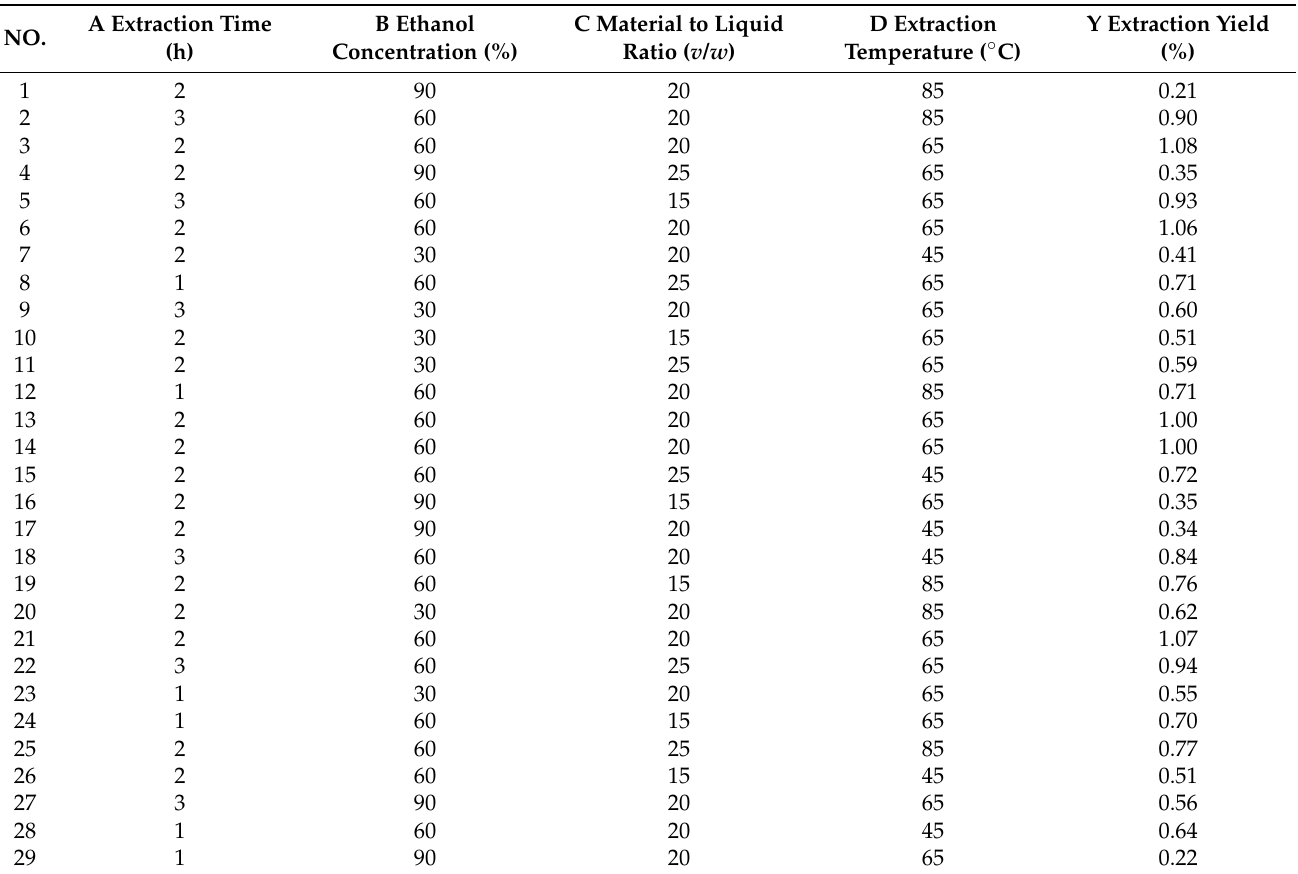
Table 1. The design of optimization